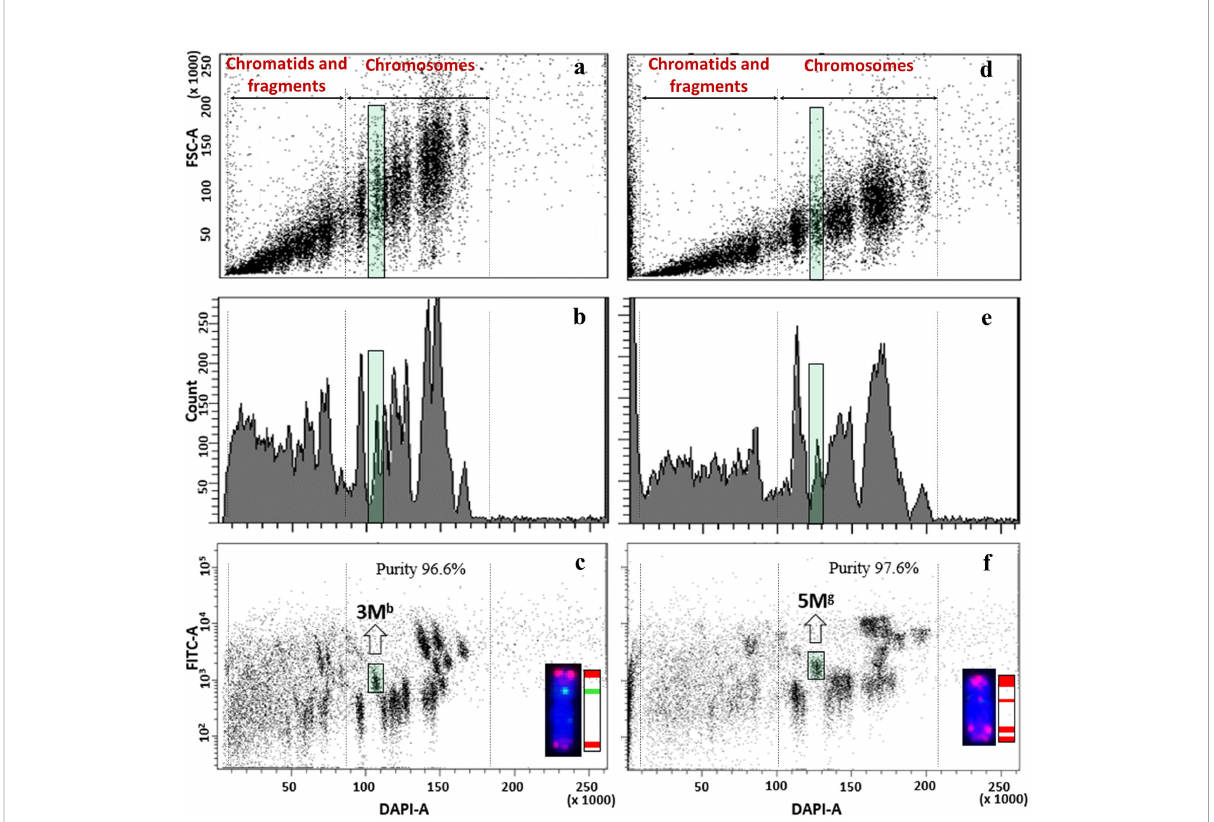
FIGURE 6 Flow cytometric analysis and sorting of Ae. biuncialis (A – C) and Ae. geniculata (D – F) chromosomes from wheat disomic addition lines. (A, D) . bivariate fl ow karyotypes DAPI (x-axis) vs. FSC (y-axis), (B, E) monovariate fl ow karyotypes DAPI (x-axis) showing count (y-axis), (C, F) bivariate fl ow karyotypes DAPI (x-axis) vs. FITC (y-axis) obtained after FISHIS with (GAA) 7 on chromosomes isolated from wheat Mv9kr1- Ae. biuncialis acc. MvGB642 (C) and wheat CS- Ae. geniculata acc. TA2899 (F) addition lines. The analysis permitted discrimination and sorting of the tetraploid Aegilops chromosomes (green boxes) in the genetic background of bread wheat (C, F) . The chromosomes (inset) were sorted at high purity and identi fi ed by FISH on microscope slides with probes for Afa family repeat (red), 45S rDNA (orange) and pSc 119.2 repeat (green). Chromosomes were counterstained with DAPI